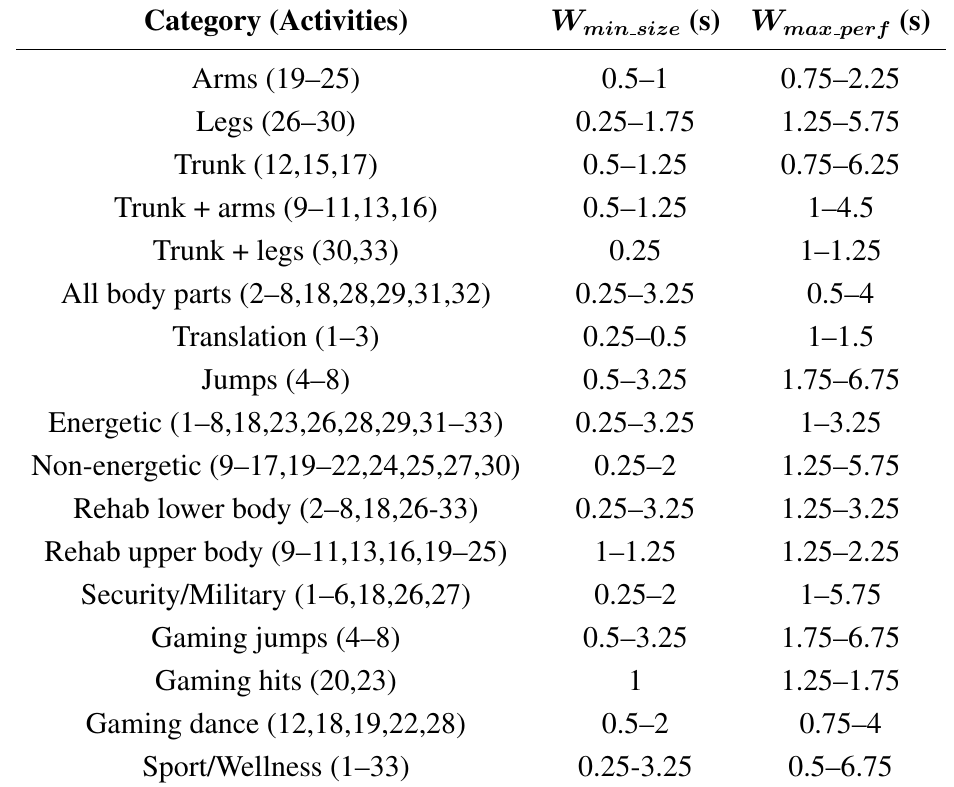
) or the recognition performance ( W max perf min size